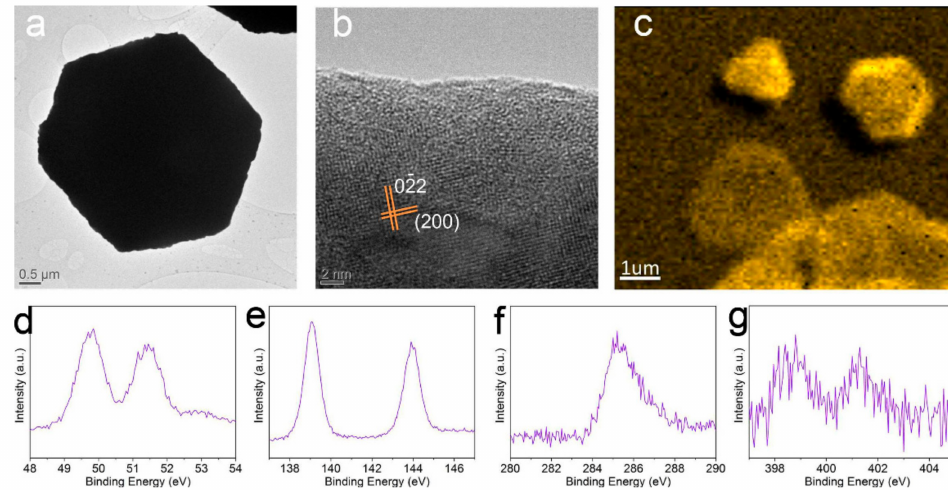
Figure 3. ( a ) TEM image of a 2D CH 3 NH 3 PbI 3 platelet; ( b ) High-resolution TEM image of the 2D CH 3 NH 3 PbI 3 platelet; ( c ) XPS mapping images of Pb element in 2D CH 3 NH 3 PbI 3 platelets acquired with SPEM; ( d – g ) XPS spectra of Pb, I, C and N elements in 2D CH 3 NH 3 PbI 3 platelets,